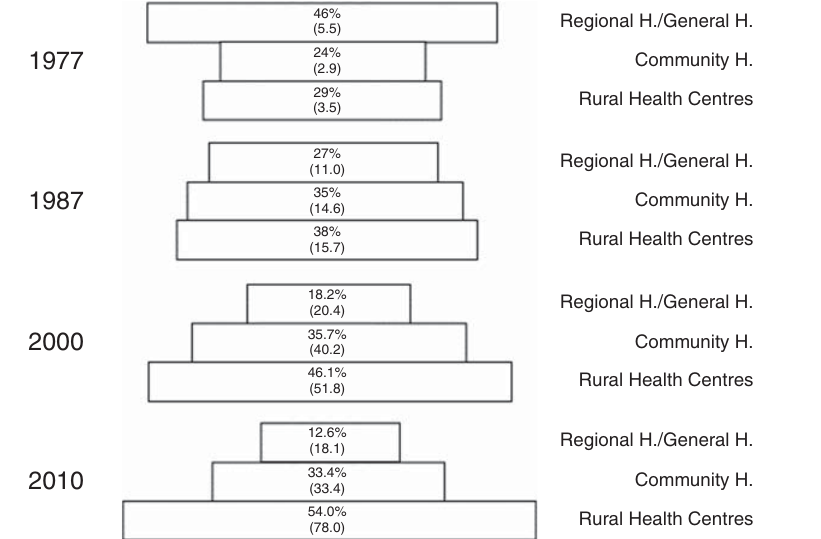
Figure 3. PHC utilisation